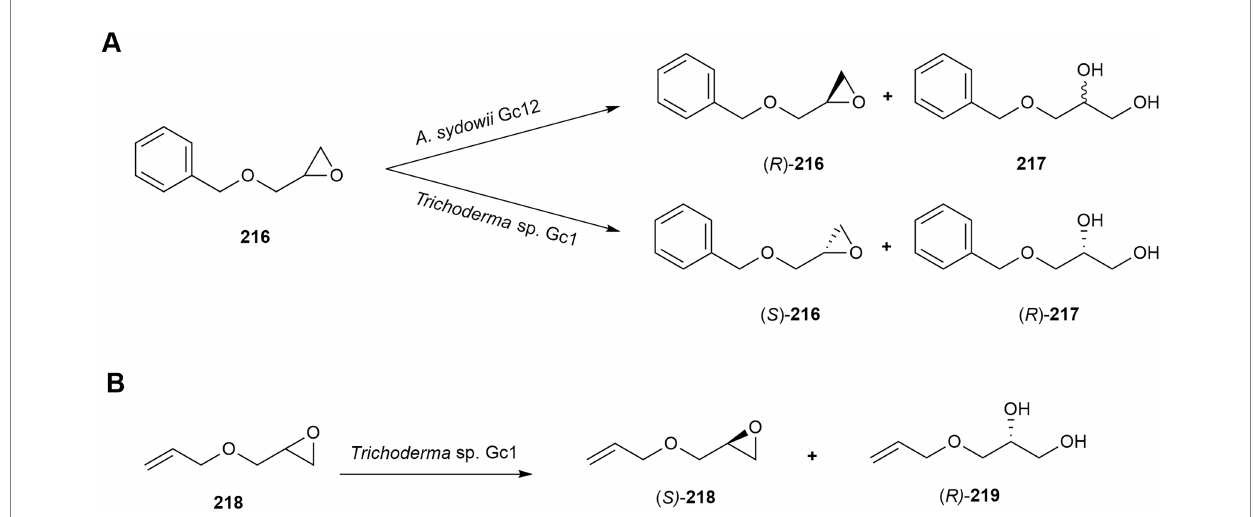
FIGURE 10 Biotransformations of miscellaneous compounds. (A) Enzymatic resolution of racemic (±)-2-(benzyloxymethyl) oxirane ( 216 ) by Aspergillus sydowii Gc12 and Trichoderma sp. Gc1 (Martins et al., 2011). (B) Hydrolysis of (±)-2-(allyloxymethyl) oxirane ( 218 ) by Trichoderma sp. Gc1 (Martins et al.,